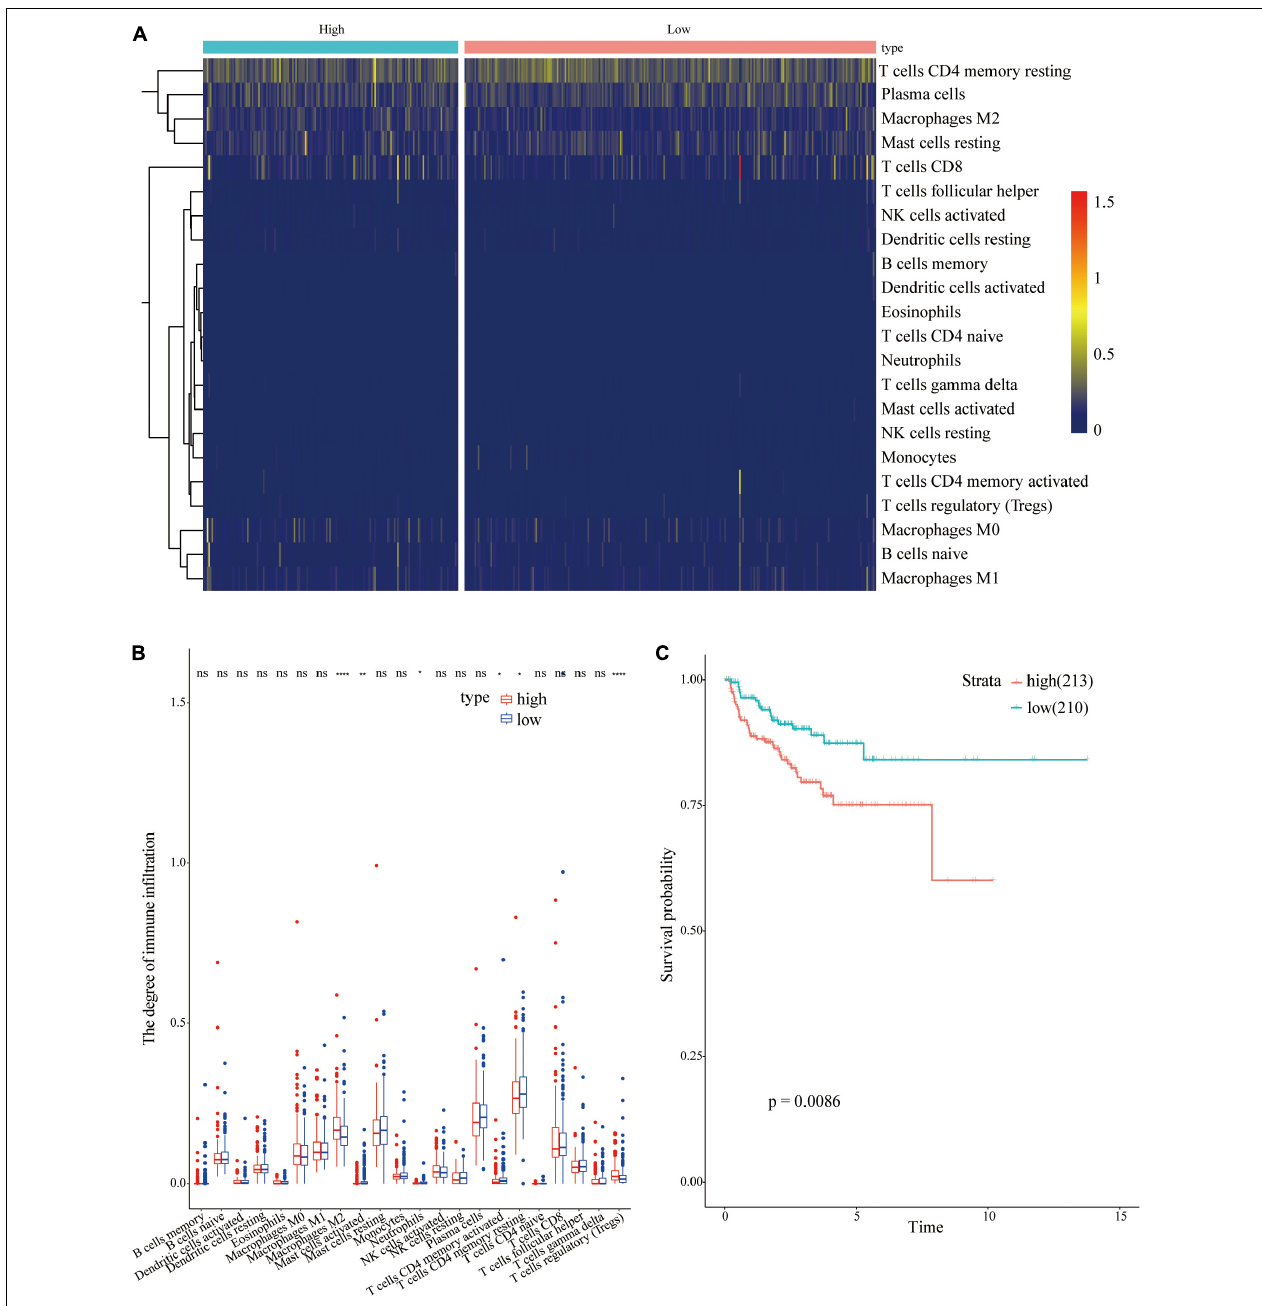
FIGURE 9 | Analysis of immune cell infiltrations in different risk groups. (A) Heatmap showing immune cell infiltration in different risk groups; (B) Differential analysis of immune cells in different risk groups; (C) Survival analysis of Macrophages M2 in PCa.